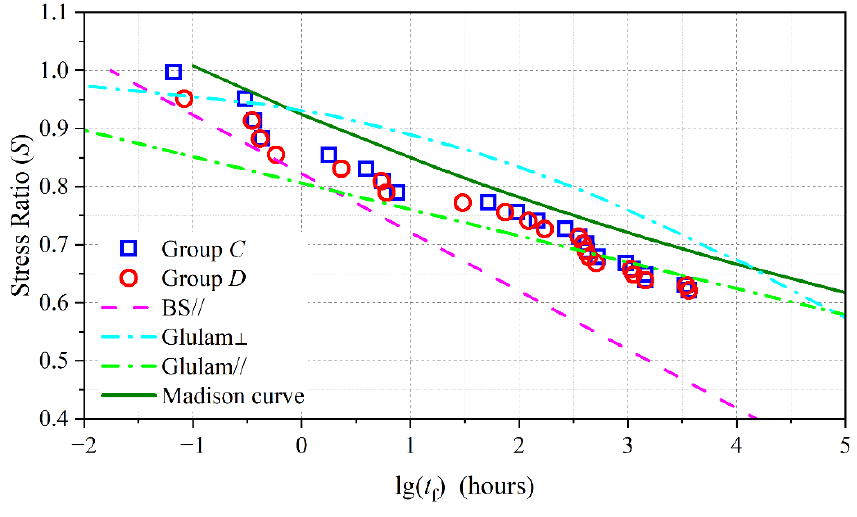
Figure 5. DOL effect of BS perpendicular to grain.